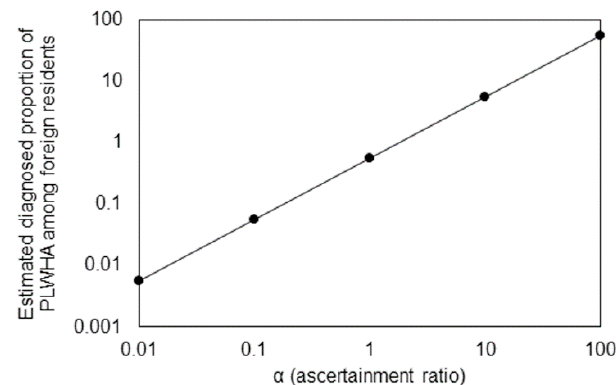
Figure 5. Sensitivity of estimate of diagnosed proportion of the cumulative number of HIV infections and acquired immunodeficiency syndrome (AIDS) cases in 2017 to variations in ascertainment ratio. It should be noted that a common logarithmic scale is used on both horizontal and vertical axes. Further, it should be noted that the vertical axis is the fraction (i.e., the value 1 is equivalent to 100%).